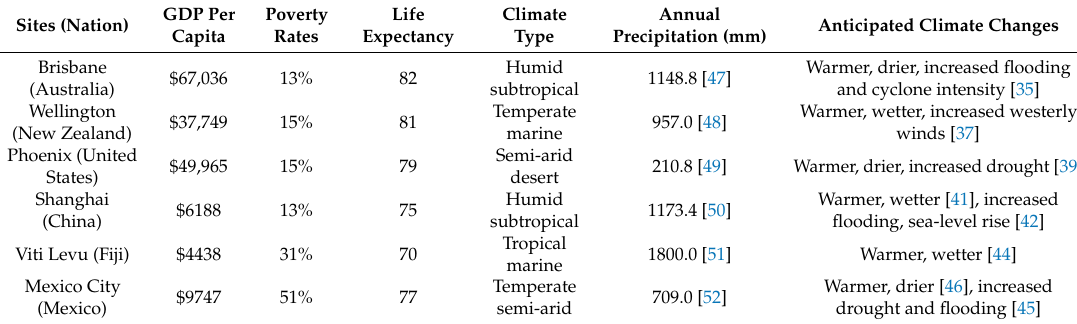
Table 1. Characteristics of study